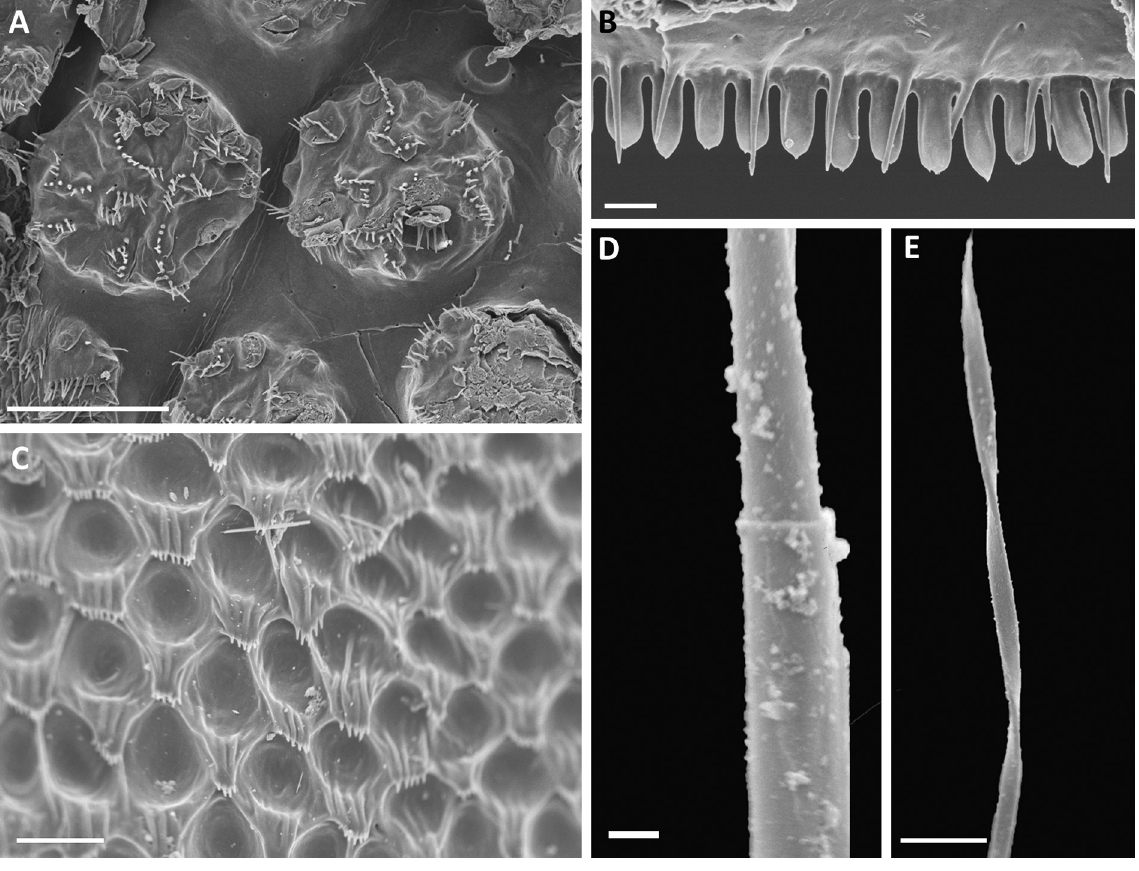
Fig. 14. Elythesmus enghoffi Hoffman, 1978, ♂♂ from Kidatu. A–B . ♂ (NHMD 621779). C–E . ♂ (NHMD 621778). A . Metazonital tubercles after mechanical removal of blackish secretion, showing rows of hair-like processes. B . Limbus. C . Microsculpture of anterior part of prozona. D – E . Metazonital setae showing articulation and flattened tip. Scale bars: A = 0.05 mm; B–C, E = 0.01 mm; D = 0.001